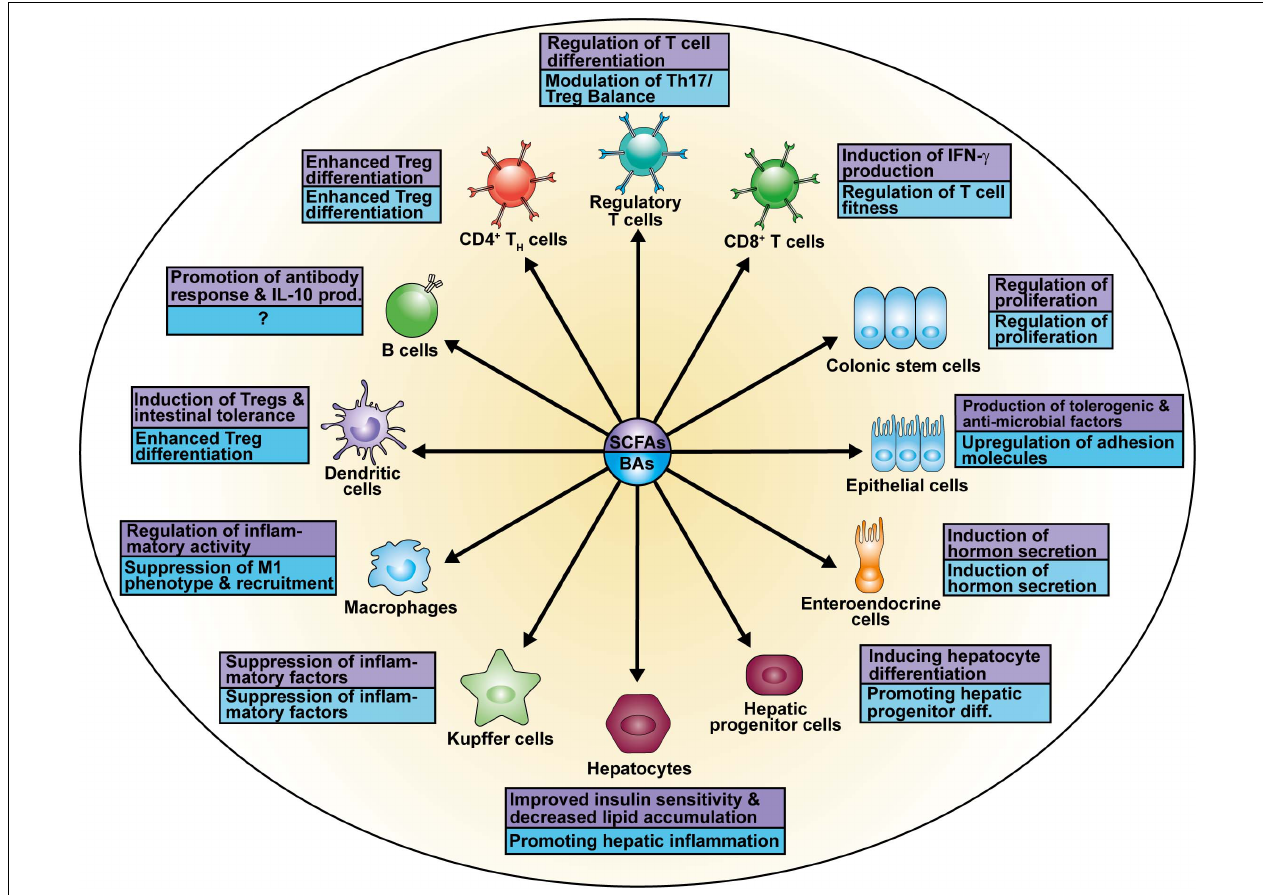
FIGURE 3 | Cell types affected by SCFAs and